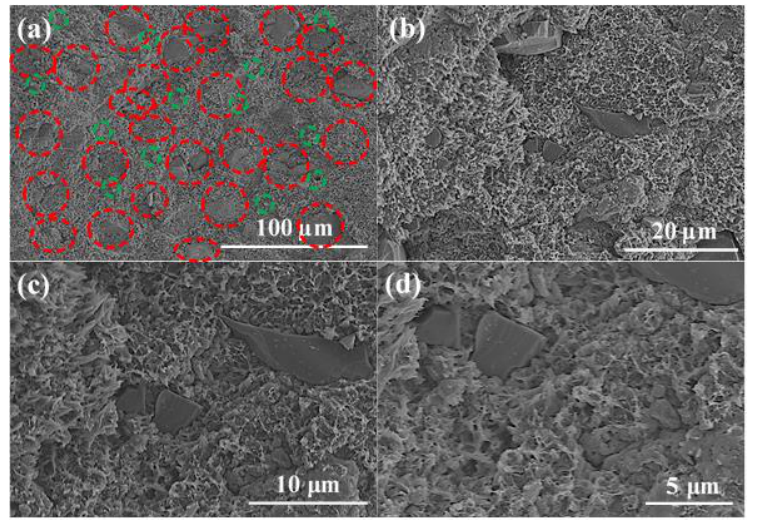
Figure 6. SEM photo of the cross-section of the B 4 C/TiO 2 /polyimide molded plate (Area 1). ( a ) B 4 C, TiO 2 particle distribution (100 μm), ( b ) B 4 C, TiO 2 particle distribution (20 μm), ( c ) B 4 C, TiO 2 particle distribution (10 μm), ( d ) B 4 C, TiO 2 particle distribution (5 μm).